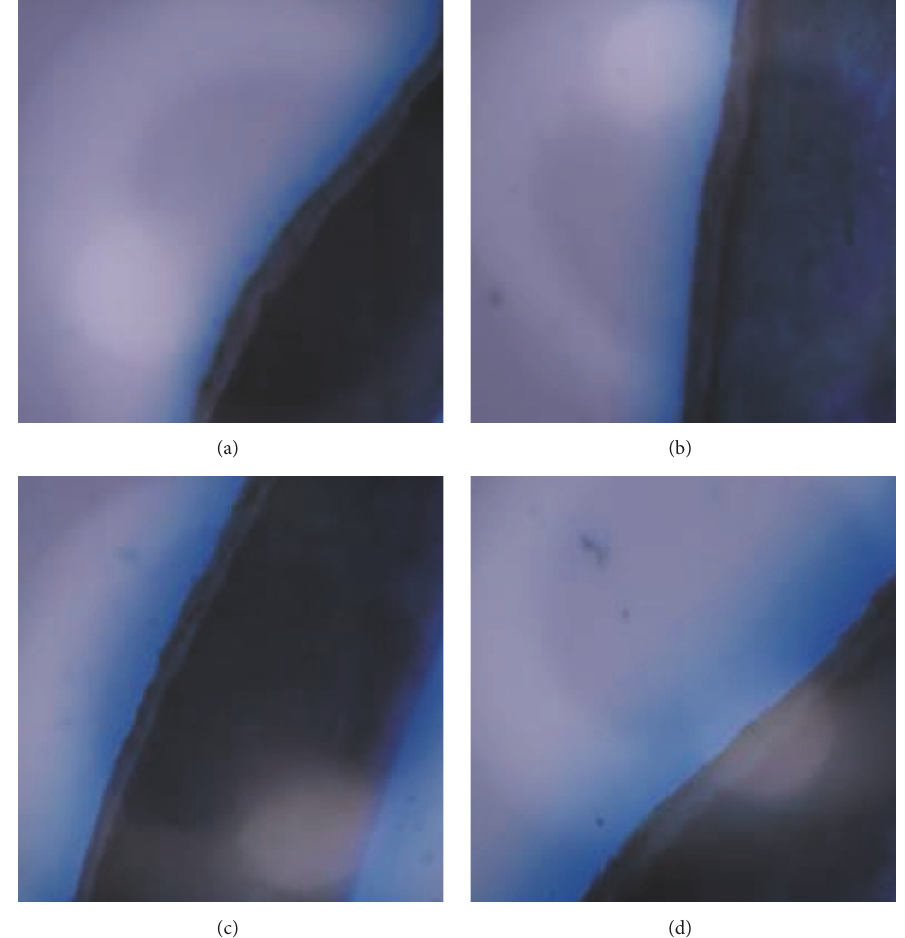
Figure 1: Micrograph of cross section of longan fruits treated by (a) UV irradiation followed by chitosan-based coating (UV + CHI), (b) UV irradiation followed by carrageenan-based coating (UV + CAR), (c) chitosan-based coating followed by UV irradiation (CHI + UV), and (d) carrageenan-based coating followed by UV irradiation (CAR +